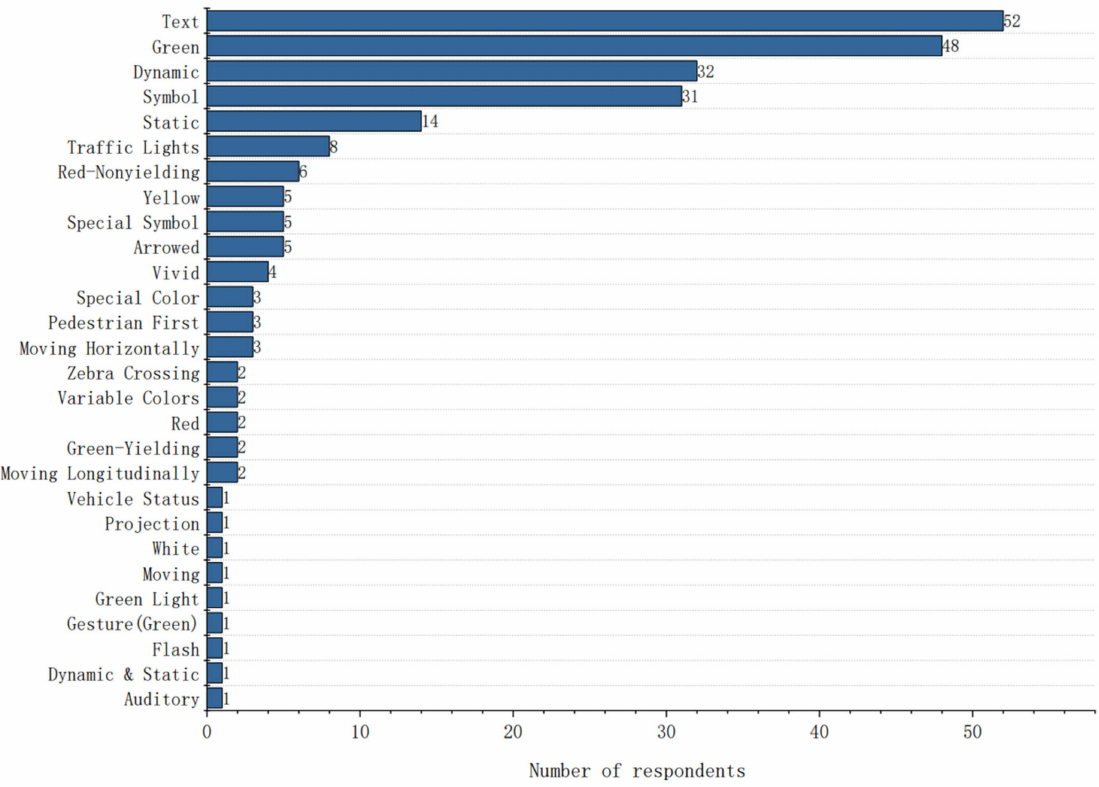
Figure 7. The word frequency statistics of preferred interaction modes between AVs and pedestrians.